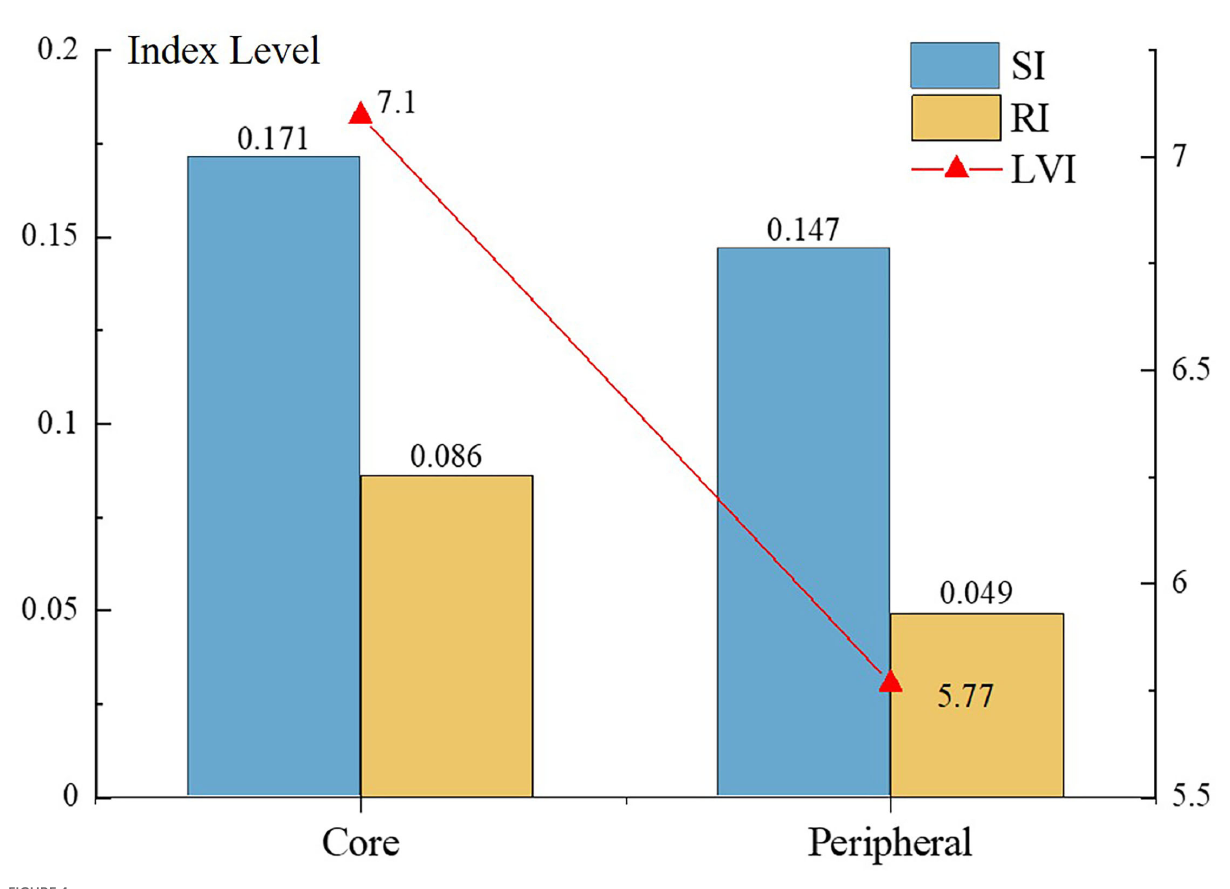
Group IC is a local tourism beneficiary group. Their livelihoods depended on tourism and local non-agricultural